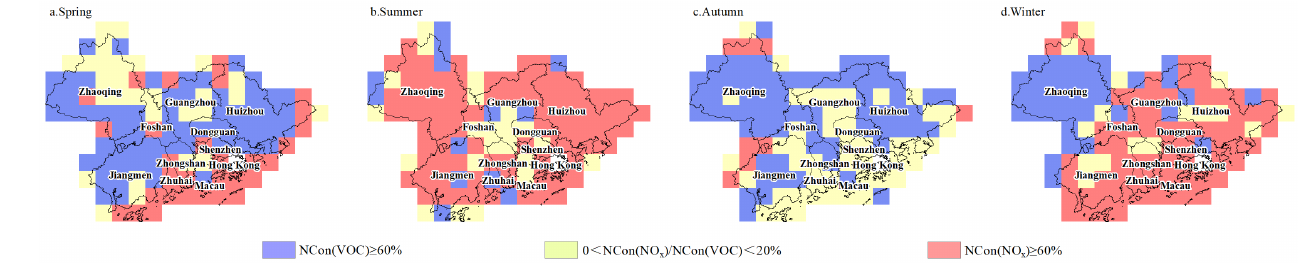
Figure 7. Distribution of the normalized contribution of seasonal NO x and NMVOC in the GBA. ( a – d ) represents the four seasons.